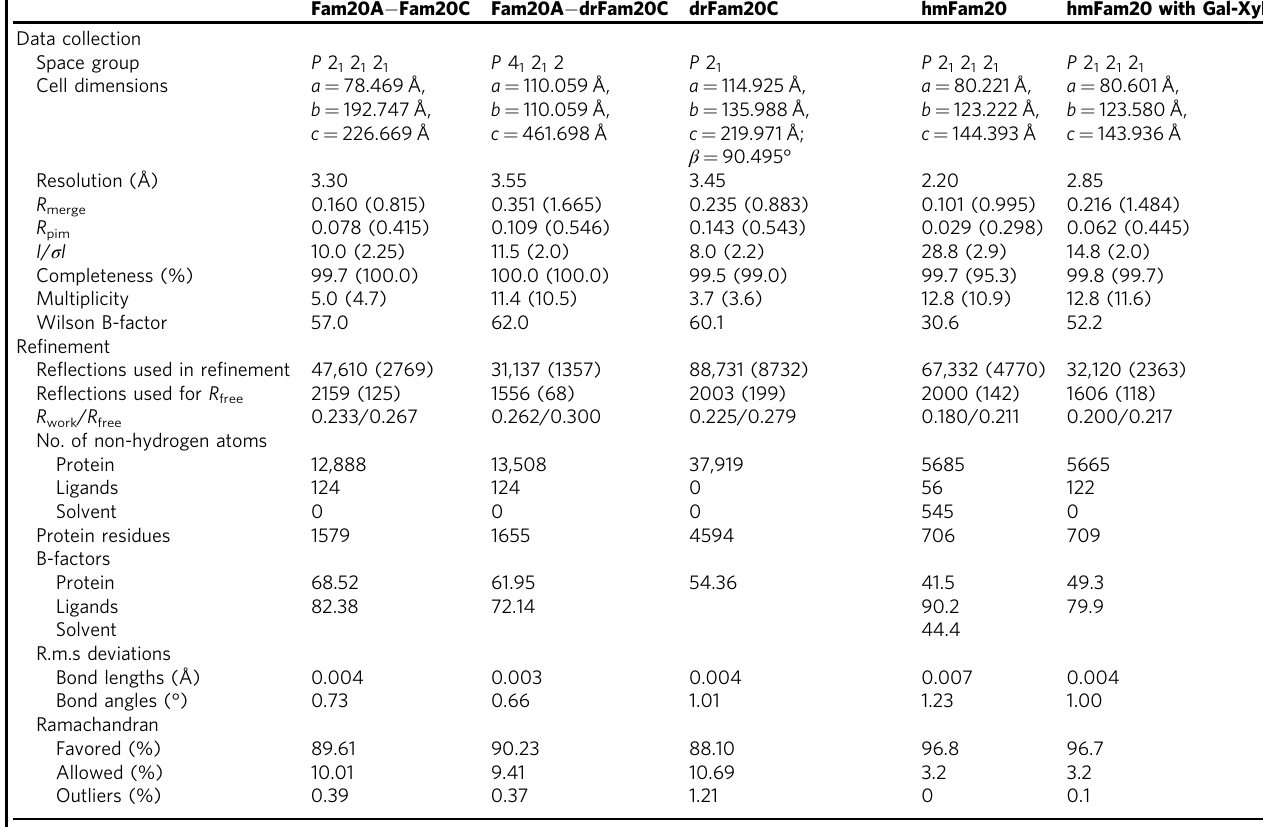
Table 1 Data collection and re fi nement